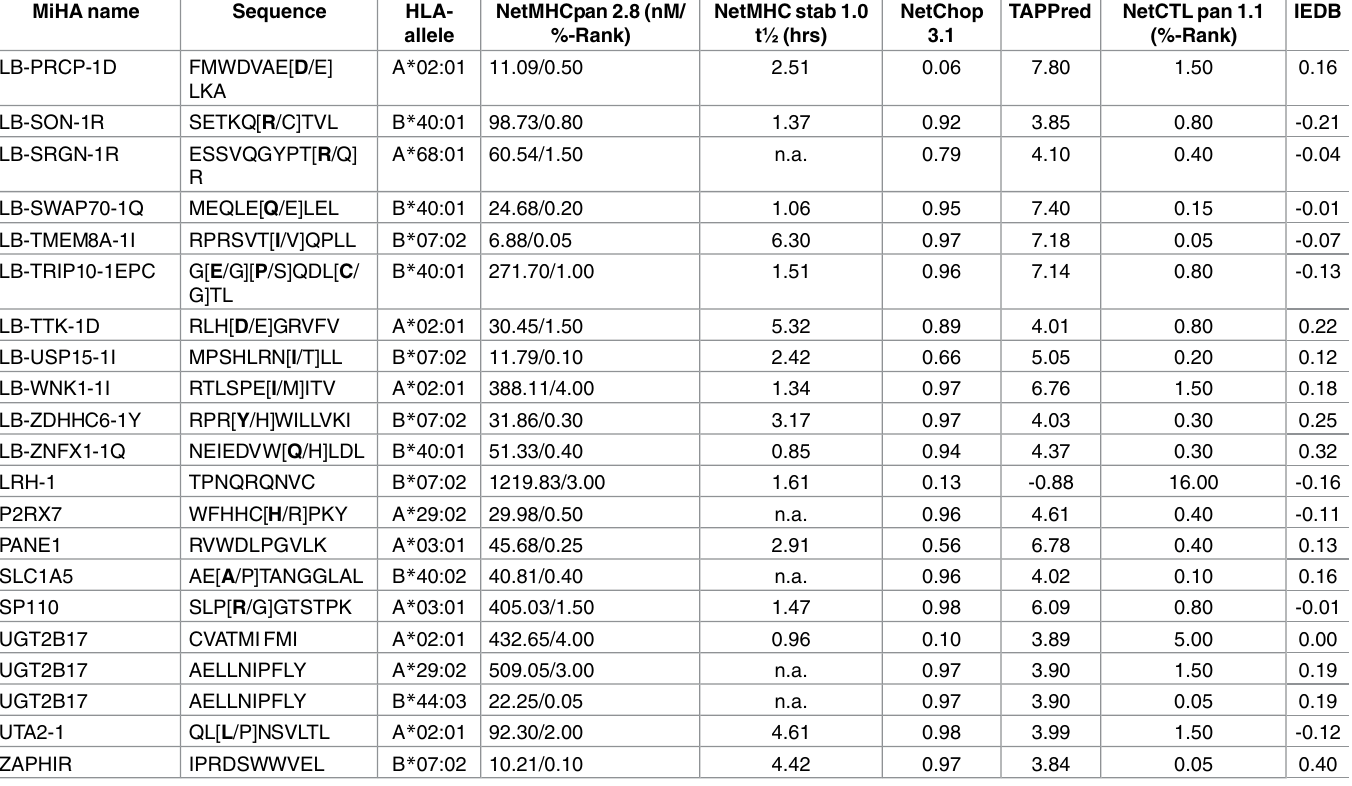
are more accurately predicted as stable peptide-HLA class I complexes by NetMHCstab 1.0 (Fig 2A). In NetMHCstab 1.0, HLA class I restriction alleles were available for 46 MiHA as shown in Table 2 and we therefore restricted the analysis to HLA-A (cid:3) 02:01- and HLA-B (cid:3) 07:02-restricted MiHA. Of the 15 HLA-A (cid:3) 02:01-restricted MiHA, 3 (20%) antigens were predicted as highly stable complexes (HS; half-life > 6 hrs), 6 (40%) antigens as weakly sta- ble complexes (WS; > 2 hrs and (cid:20) 6 hrs) and 6 (40%) antigens as non-stable complexes (NS; (cid:20) 2 hrs). Of the 18 HLA-B (cid:3) 07:02-restricted MiHA, 2 (11%), 12 (67%) and 4 (22%) antigens were predicted as HS, WS and NS complexes, respectively. In conclusion, MiHA are predicted as HLA class I binding peptides by NetMHCpan 2.8 with higher sensitivity than as stable peptide- HLA complexes by NetMHCstab 1.0. In NetMHCstab 1.0, stability predictions are based for 85% on HLA class I binding affinity as predicted by the online algorithm NetMHCcons 1.0. ROC curves were plotted for NetMHC- stab 1.0 and NetMHCcons 1.0 separately for HLA-A (cid:3) 02:01 and HLA-B (cid:3) 07:02 (S1 Fig). Com- parison of AUC showed that NetMHCstab 1.0 is slightly superior to NetMHCcons 1.0 for HLA-B (cid:3) 07:02, but not for HLA-A (cid:3) 02:01. Moreover, ROC analysis confirmed the low sensitiv- ity of NetMHCstab 1.0 to characterize MiHA, but demonstrated that the specificity of the algo- rithm is